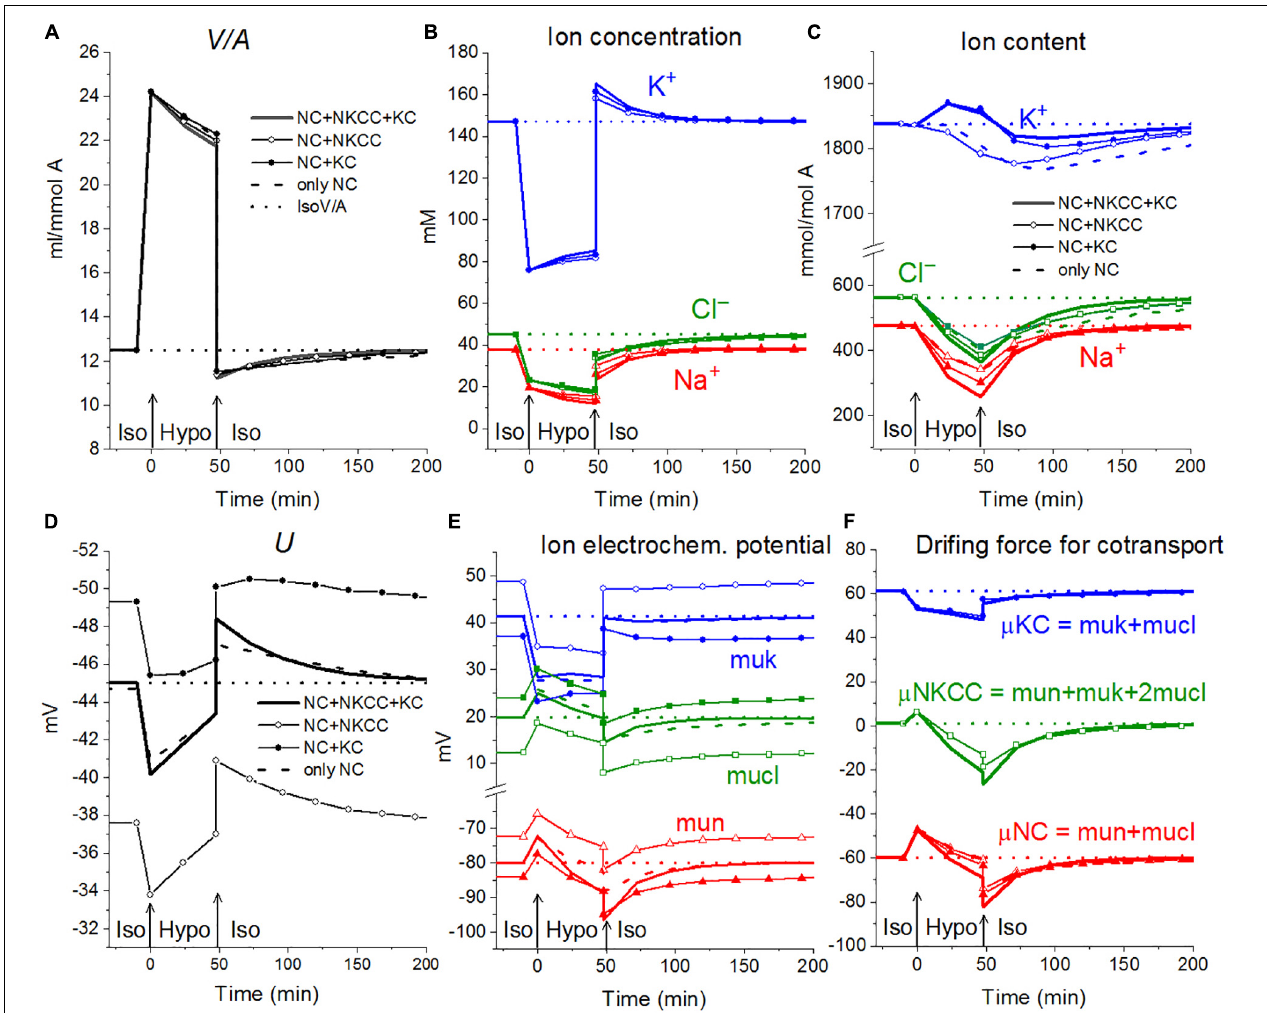
FIGURE 6 | Rearrangement of ionic homeostasis during the Iso-Hypo transition and the reverse transition to a normal medium, calculated for a system with different sets of cotransporters at the unchanged over time parameters as in U937 cells, equilibrated with standard RPMI medium. A hypoosmolar medium of 160 mOsm was obtained by decreasing the NaCl concentration by 75 mM. The parameters for the calculation are given in Table 2 , cells B